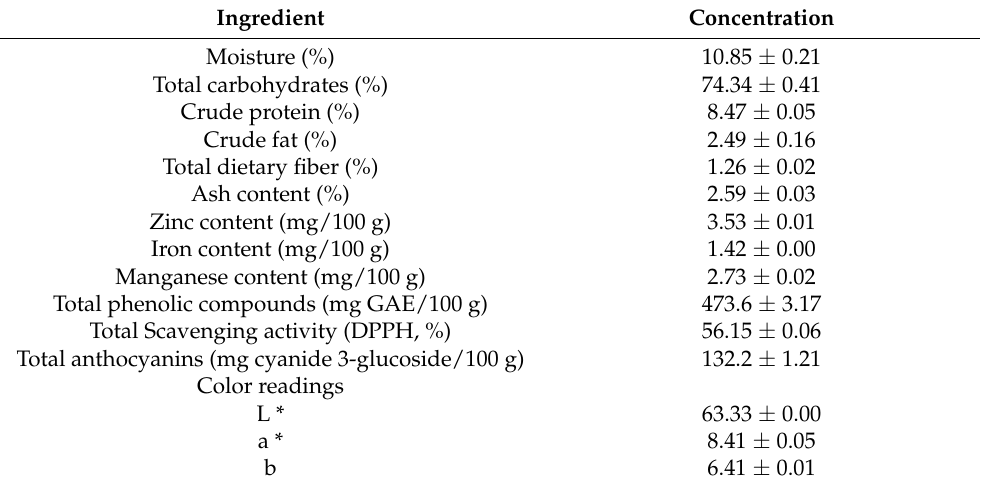
Table 2. Chemical composition, phenolic compounds, flavonoids, and anthocyanin’s of black rice powder.